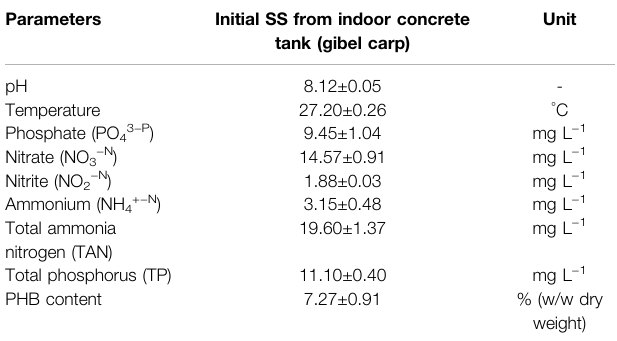
TABLE 1 | Characterization of basal suspended solids (SS) collected from aquaculture system.